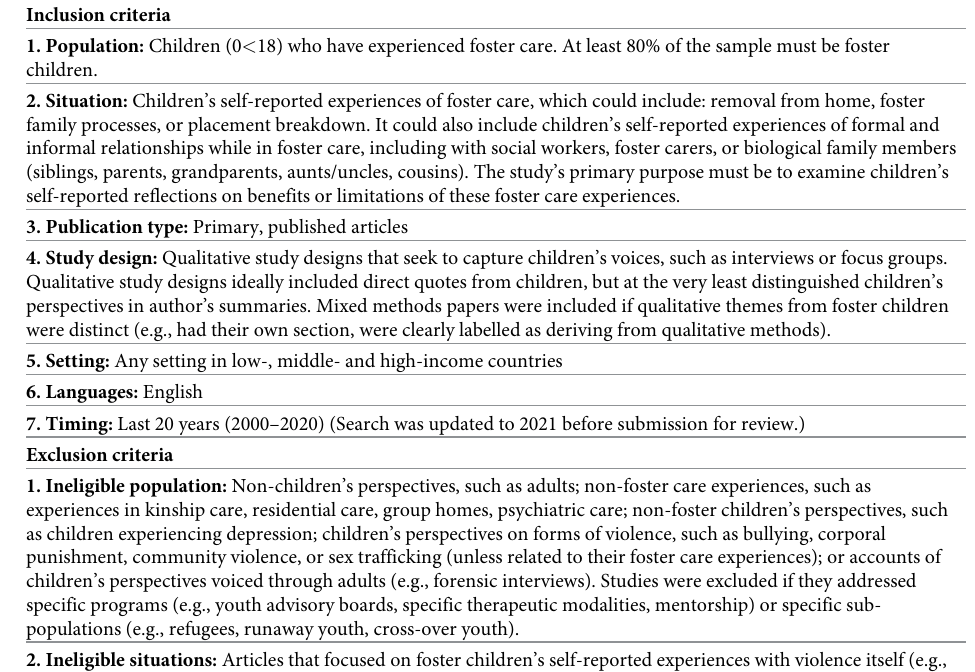
Table 1. Inclusion and exclusion